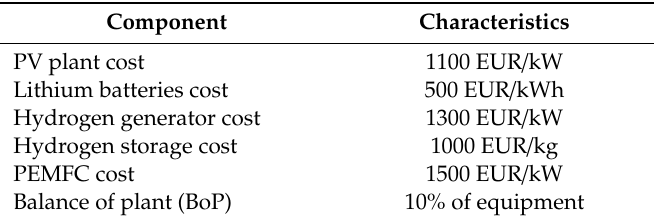
Table 2. Economic analysis assumptions